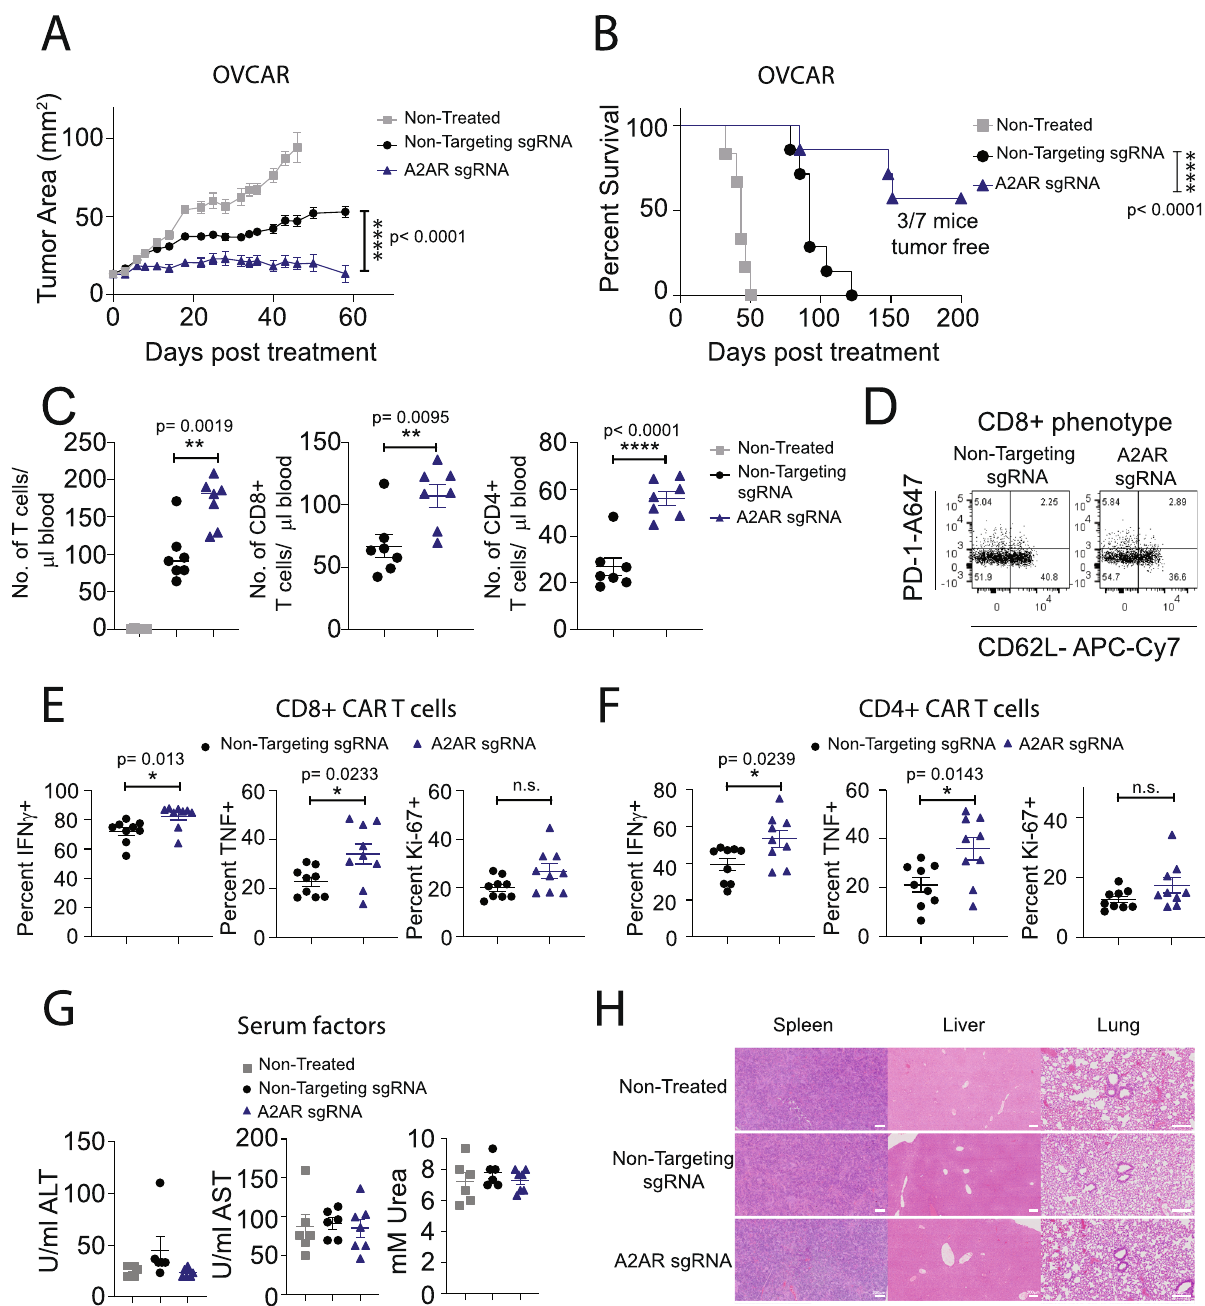
Fig. 8 Targeting A 2A R by CRISPR/Cas9 enhances the in vivo ef fi cacy of human anti-Lewis Y CAR T cells. NSG mice were injected subcutaneously with 5 × 10 6 OVCAR-3 tumor cells. Once tumors were established (15 – 20 mm 2 ), mice were irradiated (1 Gy) and treated with 9 × 10 6 anti-Lewis Y CAR T cells generated as per Fig. 6 on two subsequent days. Mice were then treated with 50,000U of IL-2 on days 0 – 4 post CAR T cell treatment. A Tumor growth, data shown are the mean ± SEM of 6 – 7 mice per group, **** p < 0.0001 per group, two-way ANOVA. B Survival determined as when tumors exceeded 80 mm 2 . **** p < 0.0001 Log-Rank test. C , D Mice were bled at day 8 post treatment. C The number of human T cells per µ l of blood was determined. Data shown are the mean ± SEM, ** p < 0.01, **** p < 0.0001 paired t test. A – C n = 6 (nontreated) or 7 (mock sgRNA or A 2A R sgRNA) mice per group. D The phenotype of CD8 + CAR T cells in terms of CD62L and PD-1 expression. Data shown are concatenated from n = 7 per group. E , F . At day 14 post treatment, tumors were excised and the proportion of ( E ) CD8 + and ( F ) CD4 + CAR T cells expressing IFN γ , TNF, and Ki-67 was determined. Data shown are the mean ± SEM of 9 mice per group. * p < 0.05 paired t test. G Serum was collected at day 40 post treatment and the concentration of de fi ned serum factors determined. Data shown as the mean ± SEM of n = 6 (nontreated, mock sgRNA) or 7 (A 2A R sgRNA) mice per group. H At the experimental endpoint, lungs, liver, and spleens were collected and sections analyzed by hematoxylin and eosin staining. One representative mouse of three per group is shown. A scale bar indicating a size of 200 µ m is shown. Source data are provided as a Source Data fi le.